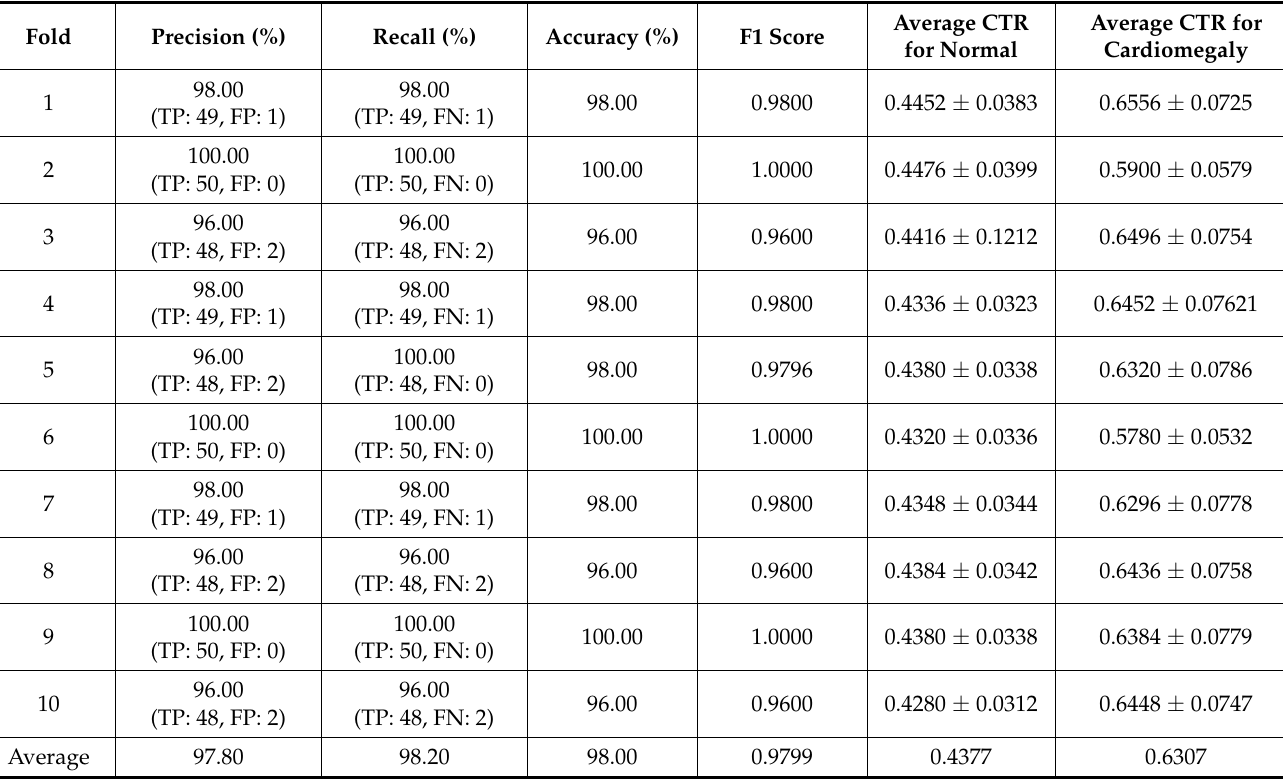
Table 3. Experimental results of 10-fold cross-validation for multilayer 2D CNN-based